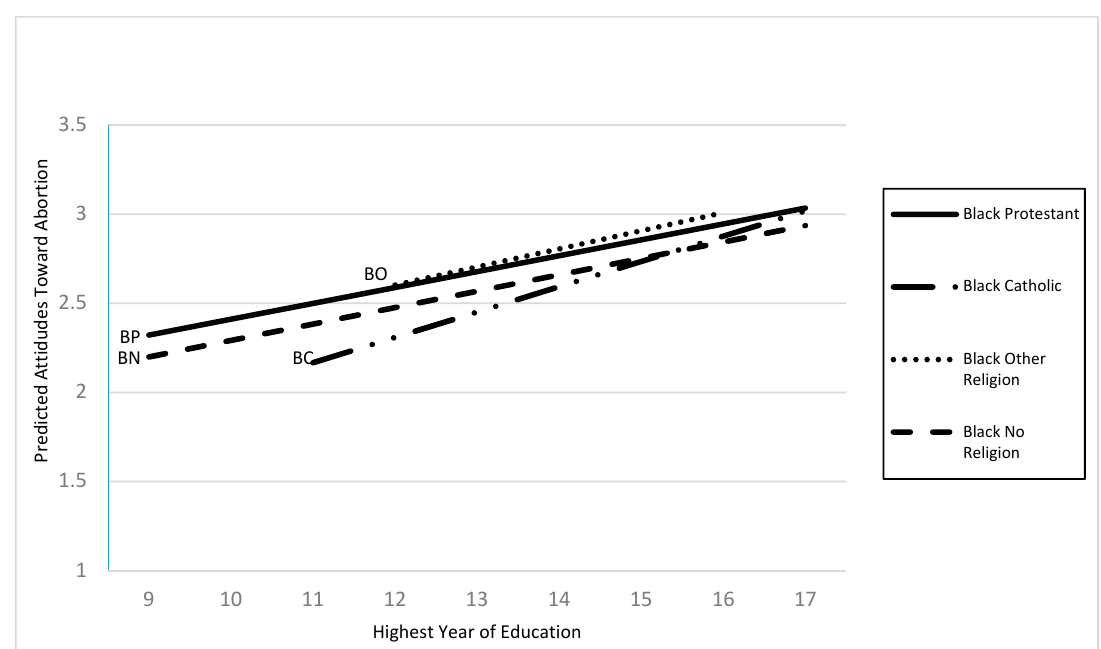
Figure 2. The interaction of religion and education on views on abortion.